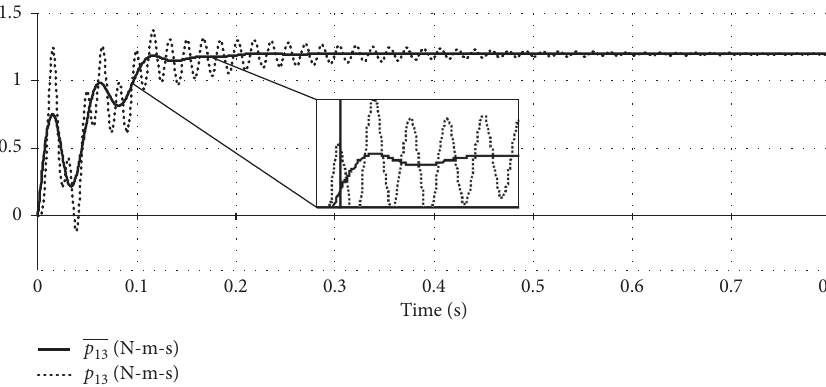
Figure 11: Performance of the slow variable and its respective quasi-steady responses: p